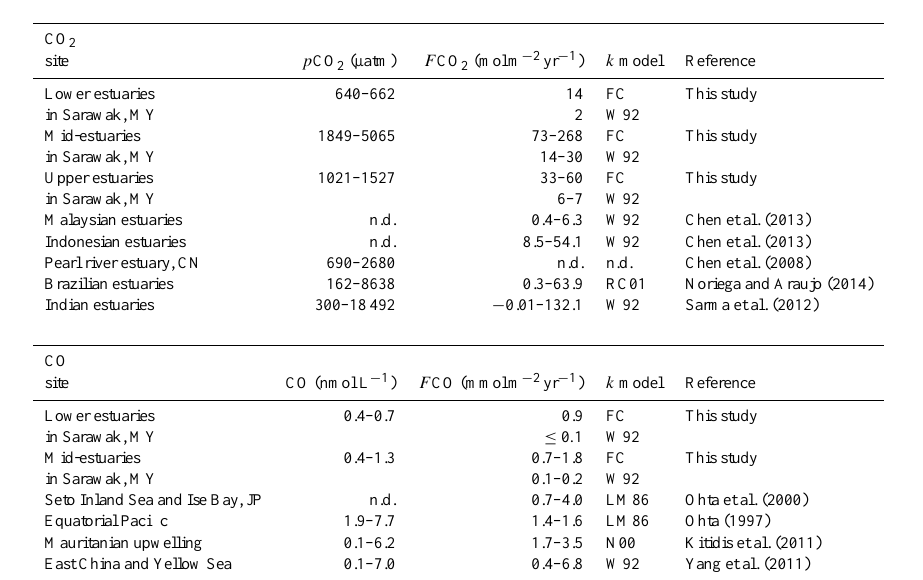
Table 5. Comparison of CO 2 and CO values for partial pressure and concentration, respectively, and fluxes for different tropical and sub- tropical